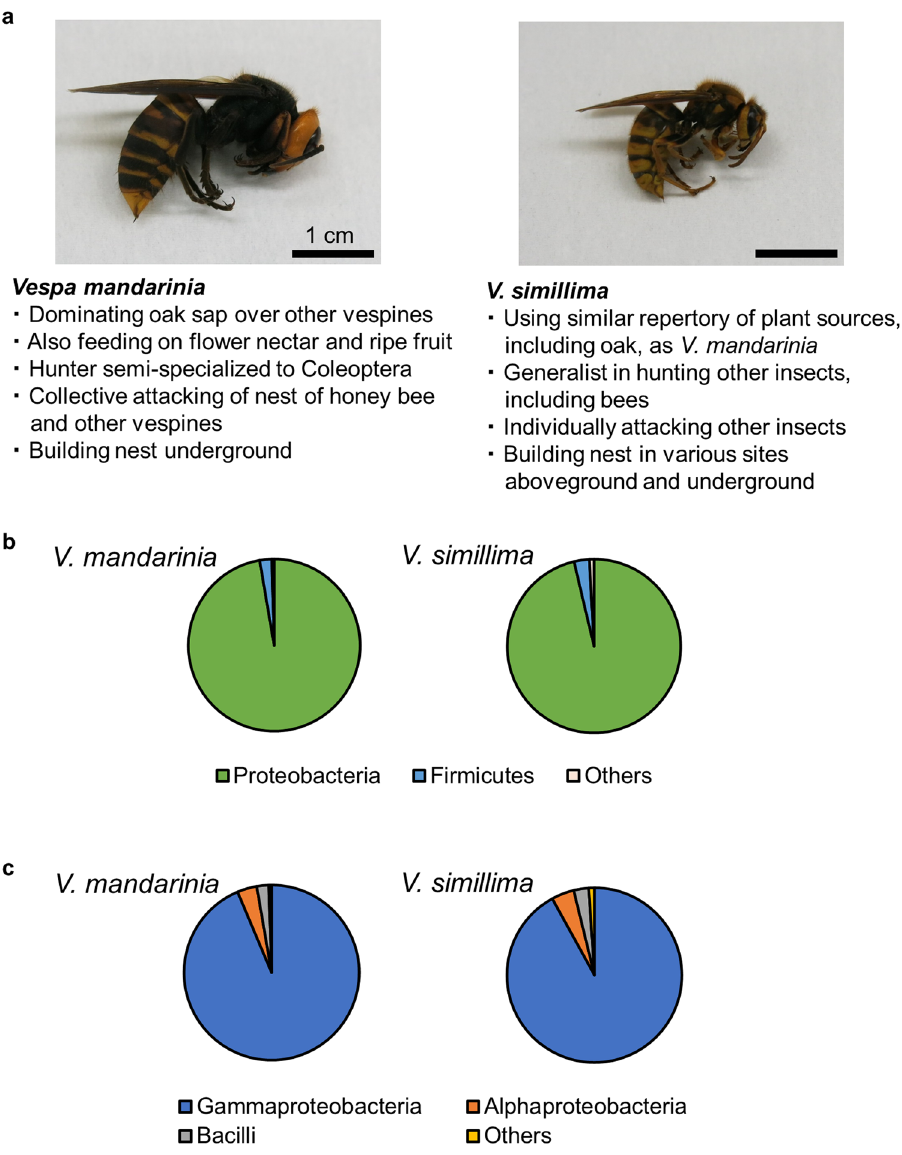
Figure 1. Overview of hornet gut microbiomes. ( a ) Photos of two hornet species analyzed in this study and characteristic ecology of each species are shown. Left, V. mandarinia ; right, V. simillima . ( b ) Averaged relative abundances of OTUs in hornet gut microbiome at the phylum level. ( c ) Same as B but the class level. Taxonomies represented less than 1% are included in ‘Others’. Taxonomic classification was performed based on SILVA. V. mandarinia , N = 9; V. simillima , N =